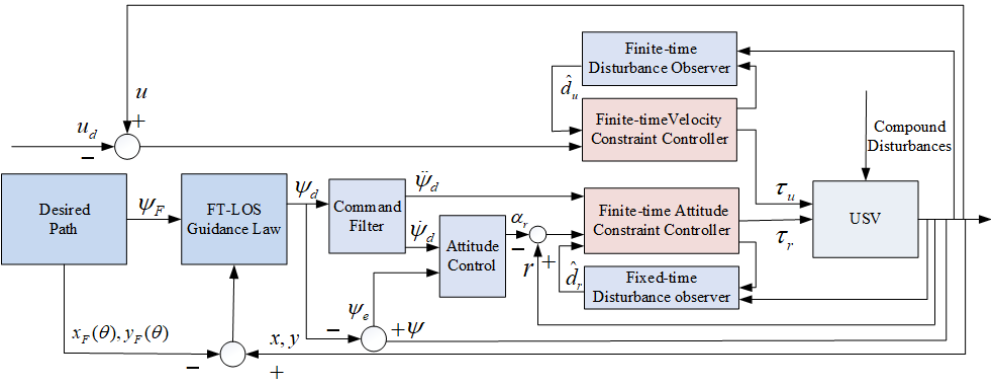
Figure 2. The block diagram of path following